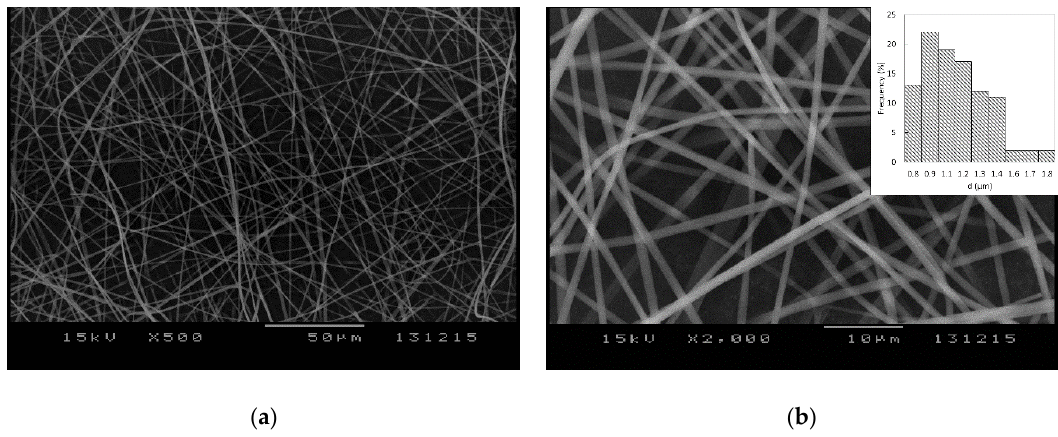
Figure 2. SEM images of the obtained electrospun microfibers at ( a ) 500 × and ( b ) 2000 × magnification and their diameter distributions ( b ).